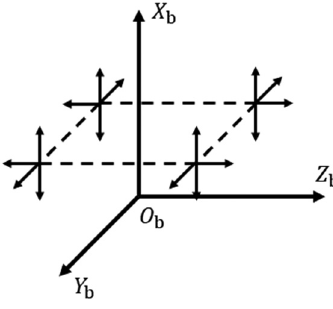
Figure 6: Three - dimensional trajectory of the VSSM + PWM